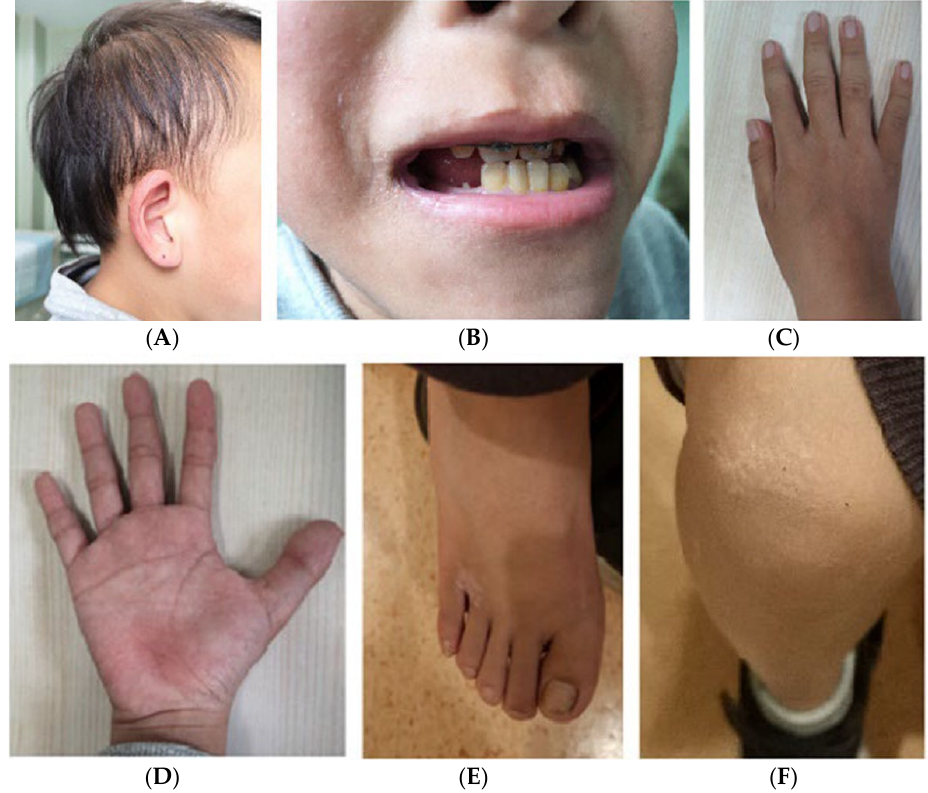
Figure 1. Clinical manifestations of the child: ( A ): Specific facial features, including thin scalp hair, a high hairline, and large ears. ( B ): Thin upper lip and small lower jaw. The teeth are not arranged in order and the bite is not correct. ( C , D ): Hands of the boy: The 2nd to 4th fingers of both hands are mildly tumid, the middle fingers of both metacarpals in the hand are short and wide, and short thumbs; ( E ): feet are characterized by a short and thick big toe deformity, ten wide, short, and thin toenails; ( F ): skin xanthomas on his knee joint.